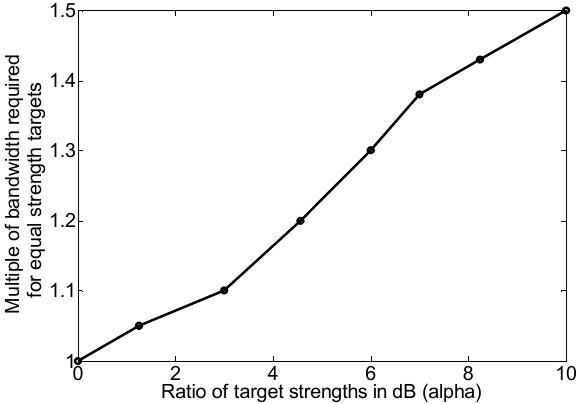
Figure 8. Dependance of bandwidth required for resolution on target strength